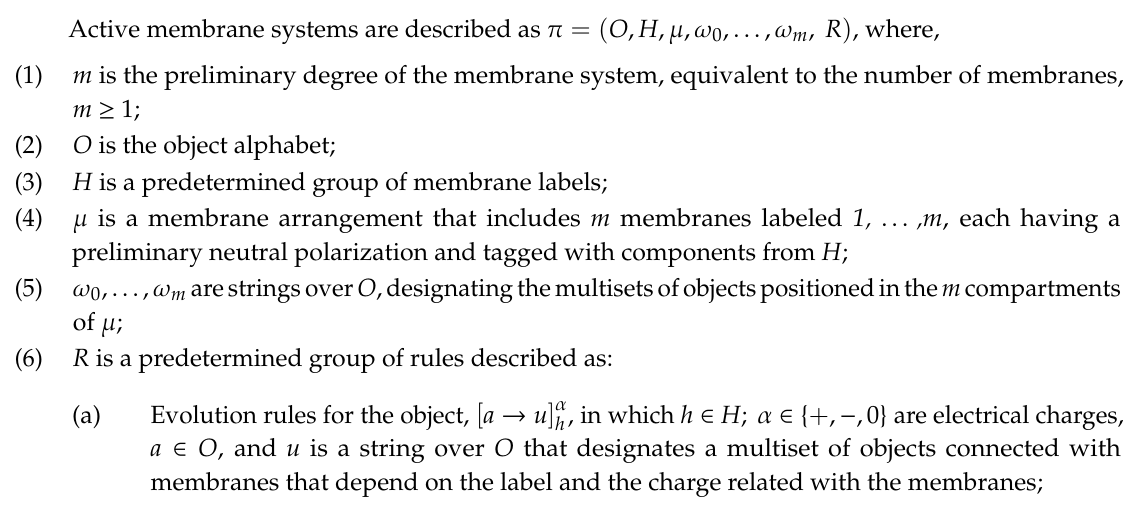
Figure 1. P-system structure. This system consists of membranes, objects, rules, and charges. Rules react to evolve objects and membranes. Charges respond to control processing.